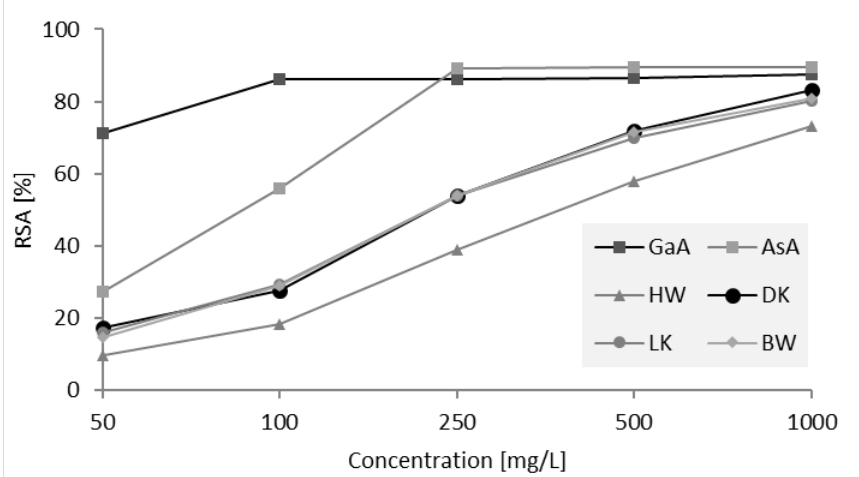
Figure 8. Radical scavenging activity (RSA, %) for reference antioxidants (gallic (GaA) and ascorbic acid (AsA)) and for hydrophilic extracts of heartwood (HW), knotwood of dead branches (dead knot, DK), knotwood of living branches (living knot, LK) and branchwood (BW) of silver fir ( A. alba ). The reference and the extract solutions were tested at concentrations of 50 mg/L, 100 mg/L, 250 mg/L, 500 mg/L, and 1000 mg/L.